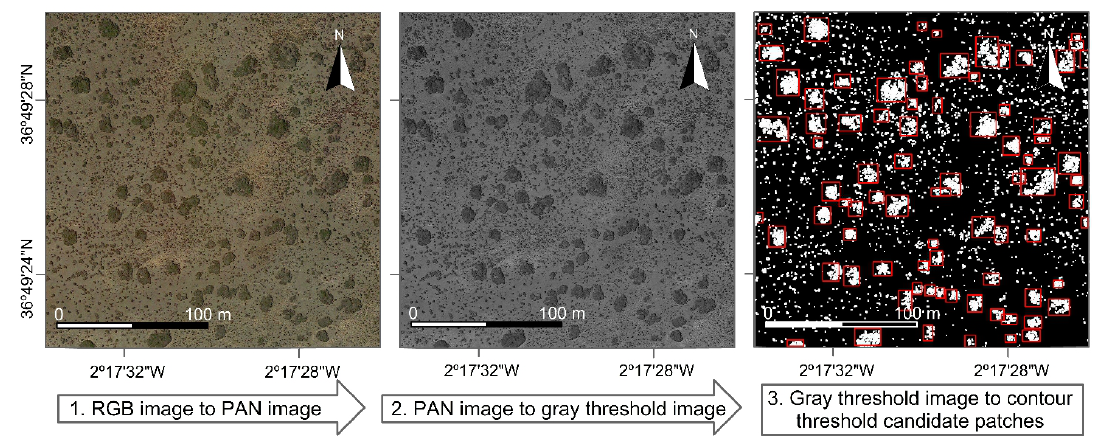
Figure 5. The used detection proposals technique consisted of, first, converting the three band image into one gray-scale band image (PAN), second, converting the gray-scale image into a binary image based on a 100 over 256 digital value threshold, and third, detecting Ziziphus lotus shrubs only in pixels with a digital value greater than 100. The 78 candidate patches identified in Test-zone-1 are labeled with red contour in the right panel (the 53 candidates in Test-zone-2 are not